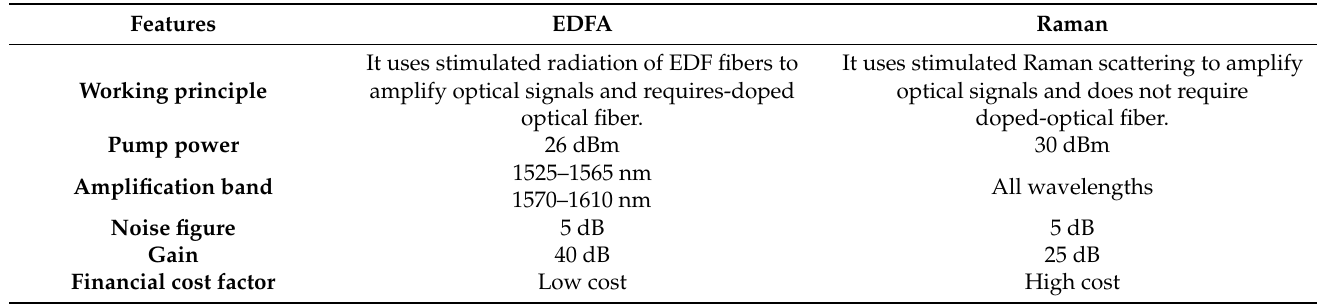
Table 2. Comparison between the features of EDFA and Raman